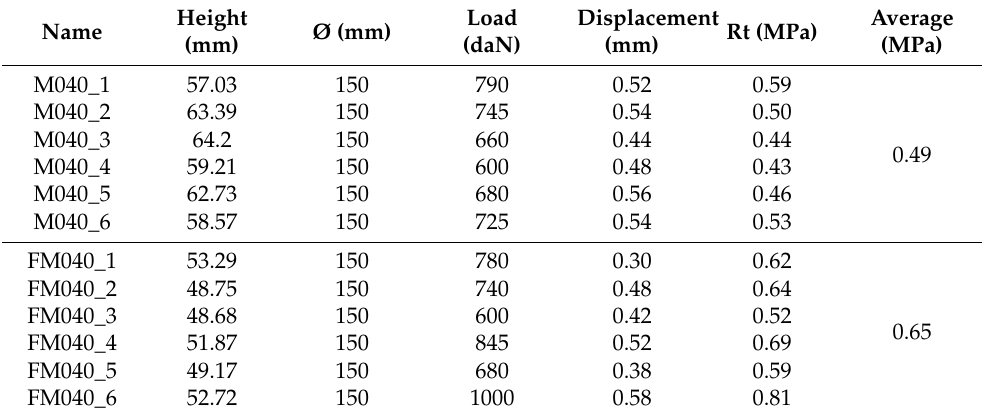
Table 4. Indirect tensile strength (ITS)